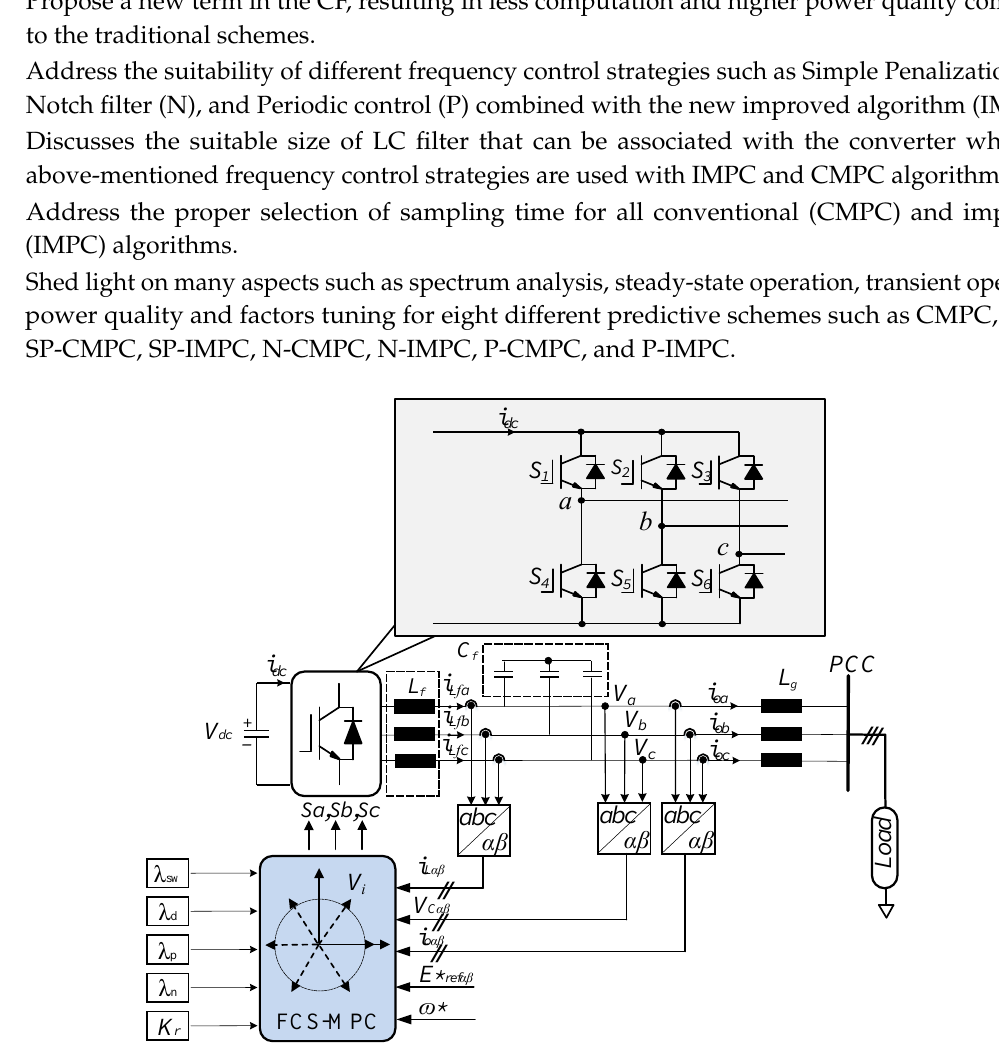
Figure 2. Power circuit and FCS-MPC control structure of a standalone inverter for microgrid